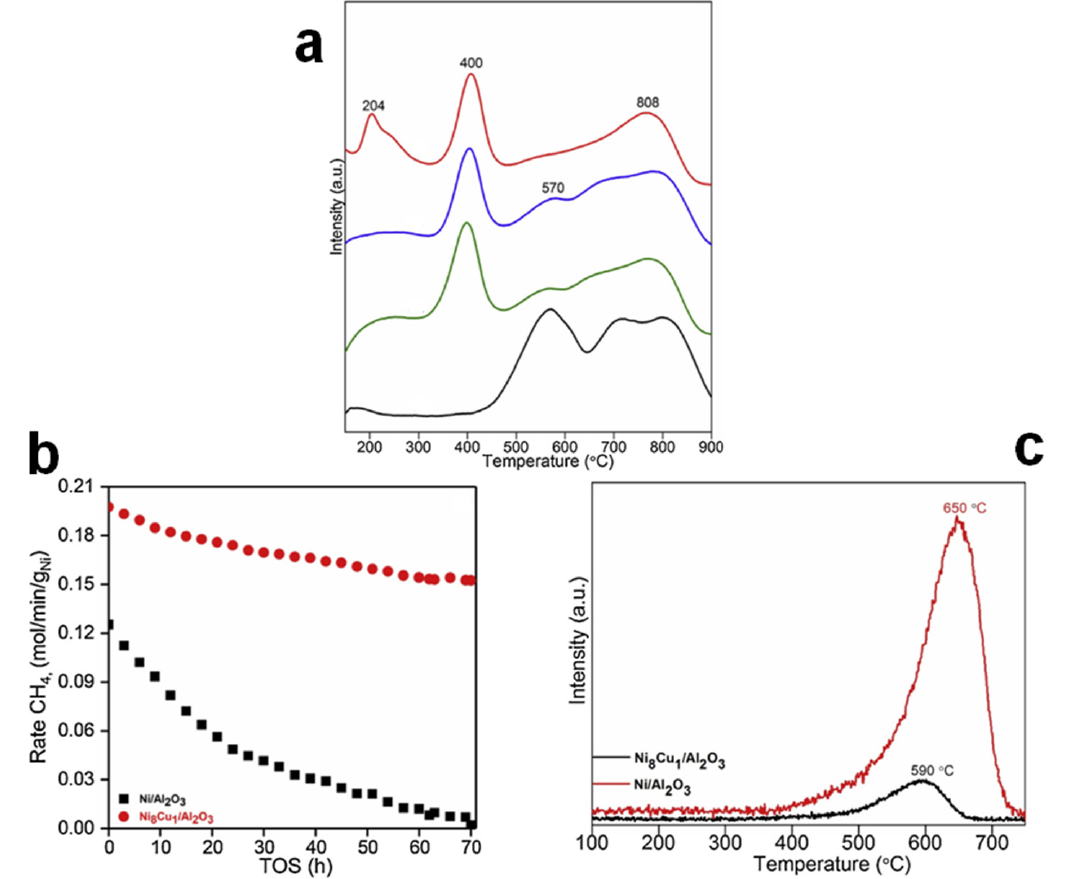
Figure 3. ( a ) H 2 -TPR analysis of fresh calcined Ni/ γ -Al 2 O 3 (black), Ni10Cu1/ γ -Al 2 O 3 (green), Ni8Cu1/ γ -Al 2 O 3 (blue) and Ni3Cu1/ γ -Al 2 O 3 (red) samples. ( b ) CH 4 conversions rates vs. TOS for the CO 2 reforming of methane at 650 ◦ C. ( c ) O 2 -TPO profile of spent catalysts after DRM performance at 650 ◦ C for 70 h TOS. Reproduced with permission from [66]. Copyright 2020,